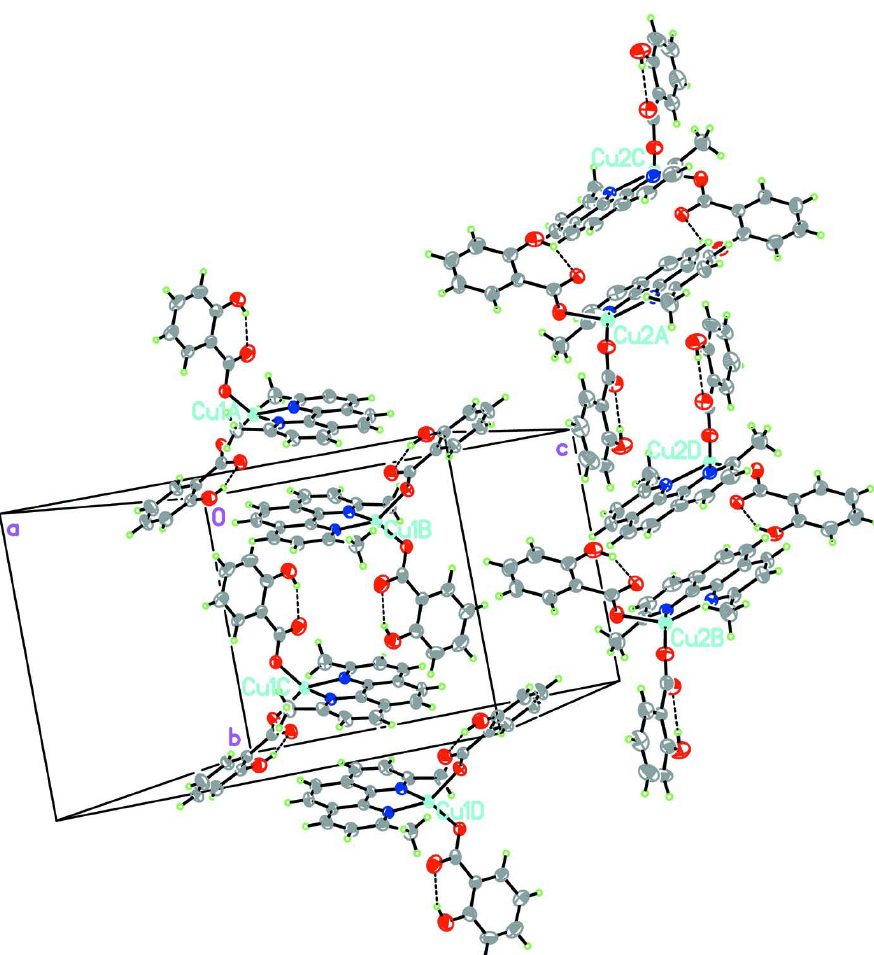
Figure 2 π — π interactions of neighboring molecules and intramolecular hydrogen bonds in the crystal structure of (I).[symmetry code: (Cu1A) x , y - 1, z ; (Cu1B) - x + 1, - y + 1, - z + 1; (Cu1D) - x + 1, - y + 2, - z + 1; (Cu2A) - x + 2, y - 1/2, - z + 3/2; (Cu2B) - x + 2, y + 1/2, - z + 3/2; (Cu2C) x , - y - 1/2, z + 3/2; (Cu2D) x , - y + 1/2, z +